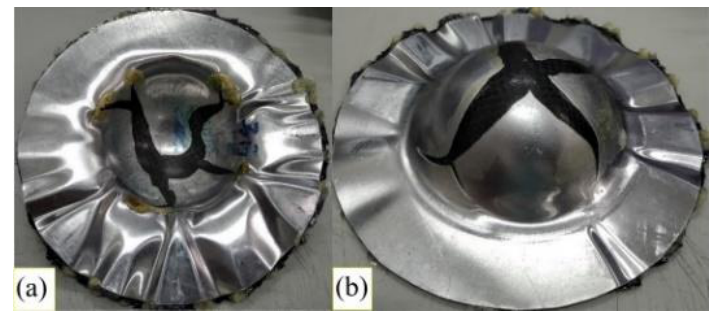
Figure 8. Deep drawing of Al 1050-composite sandwich: ( a ) front view, ( b ) back view.